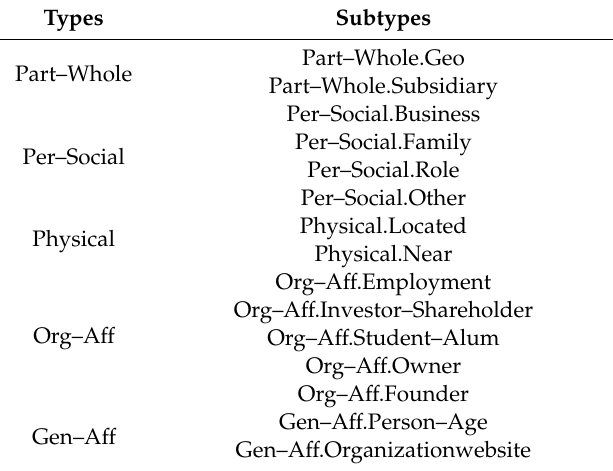
Table 5. Input format of entity